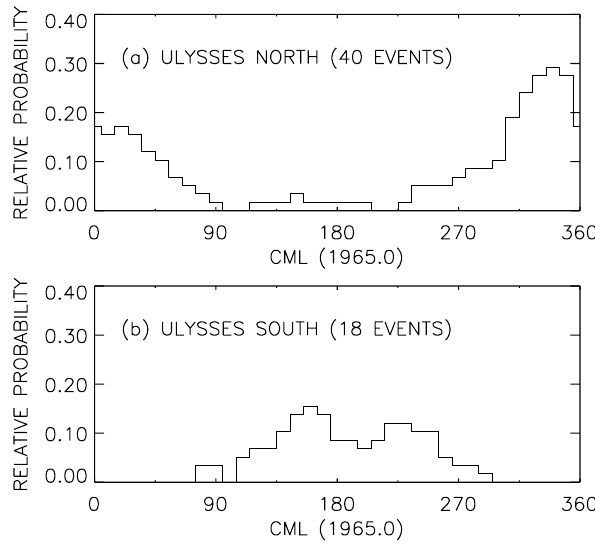
Fig. 5. Relative occurrence probability of the HOM observed when the Ulysses was (a) north of the jovicentric equatorial plane and (b) south of the jovicentric equatorial